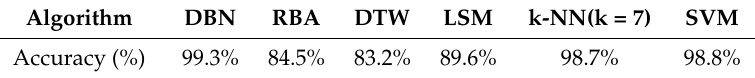
Table 6. Correct differentiation rates of different algorithm.